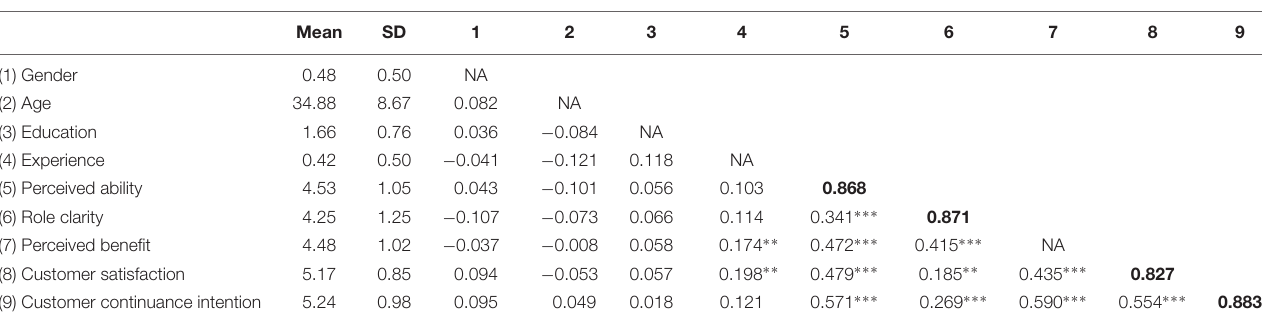
TABLE 3 | The means, SDs, and correlation coefficients.